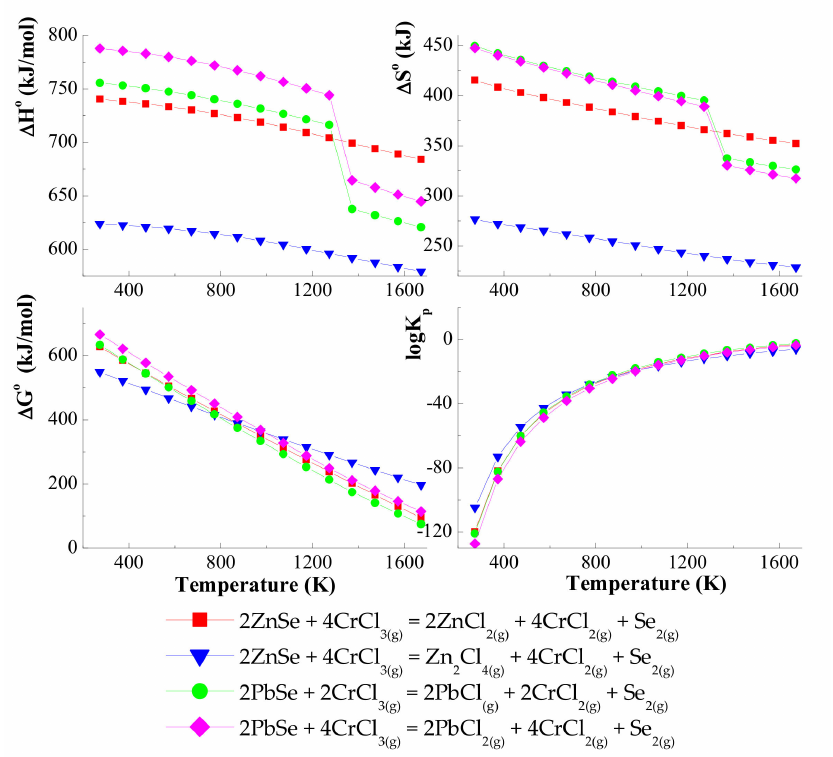
Figure 1. The dependence of the thermodynamic parameters vs. temperature T for the ZnSe and PbSe with CrCl 3 as a transport